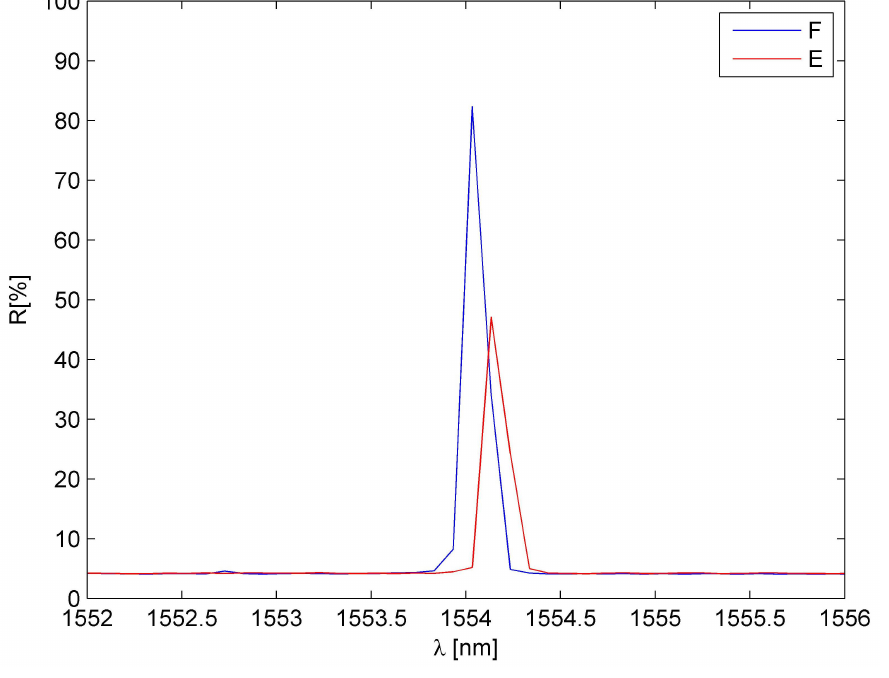
Figure 2. A comparison of FBG sensor spectra: F—free, E—after